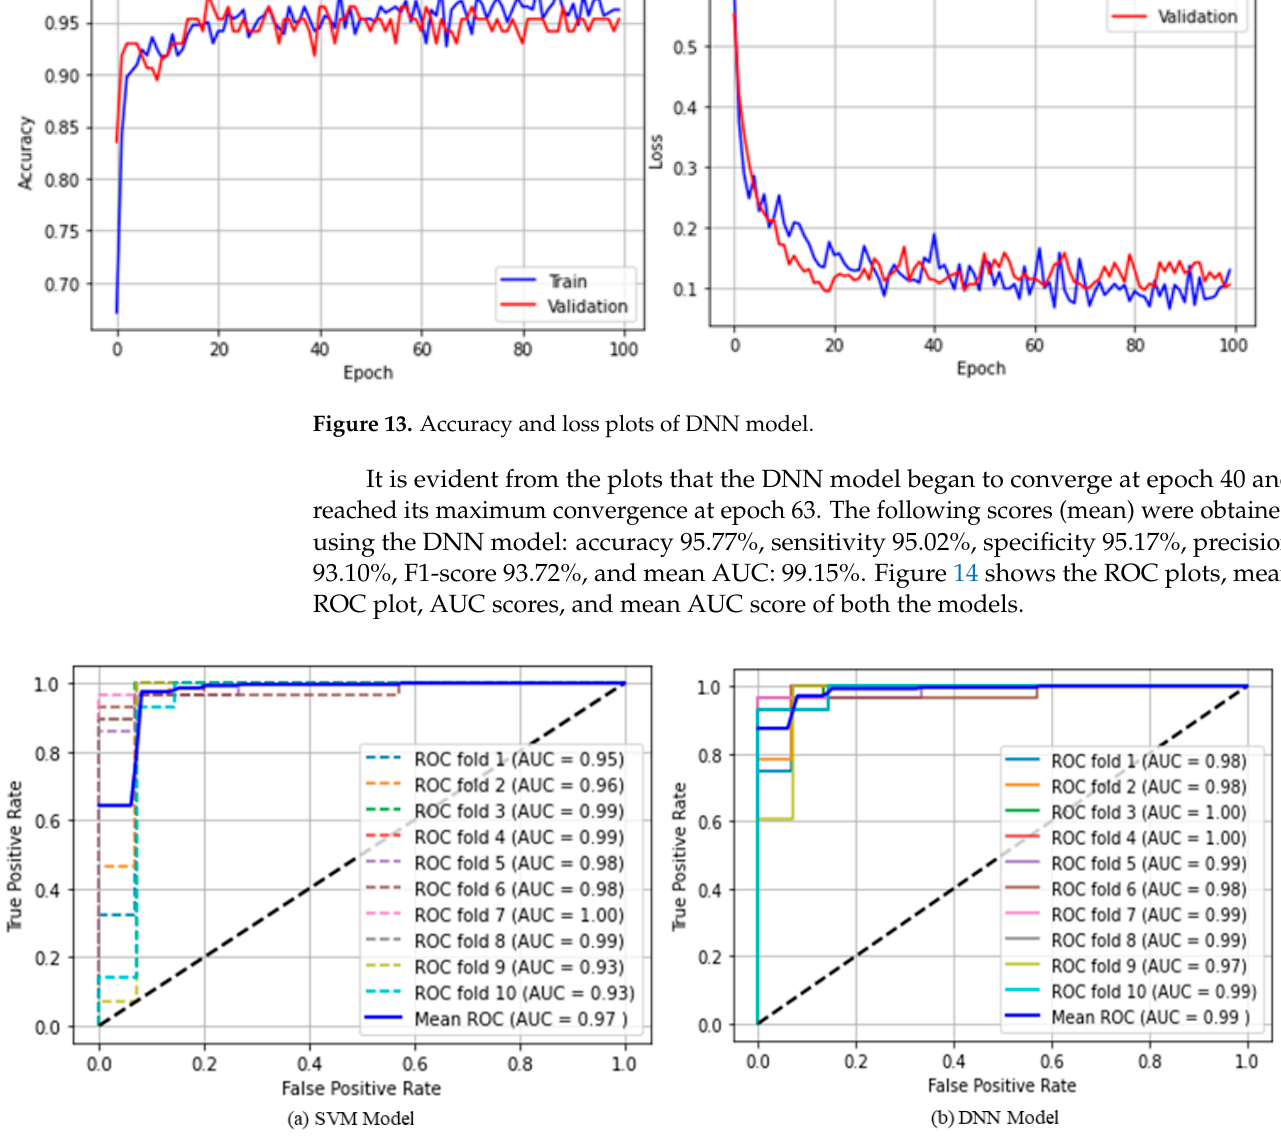
Figure 14. Cross validated scores of SVM and DNN models on test data.